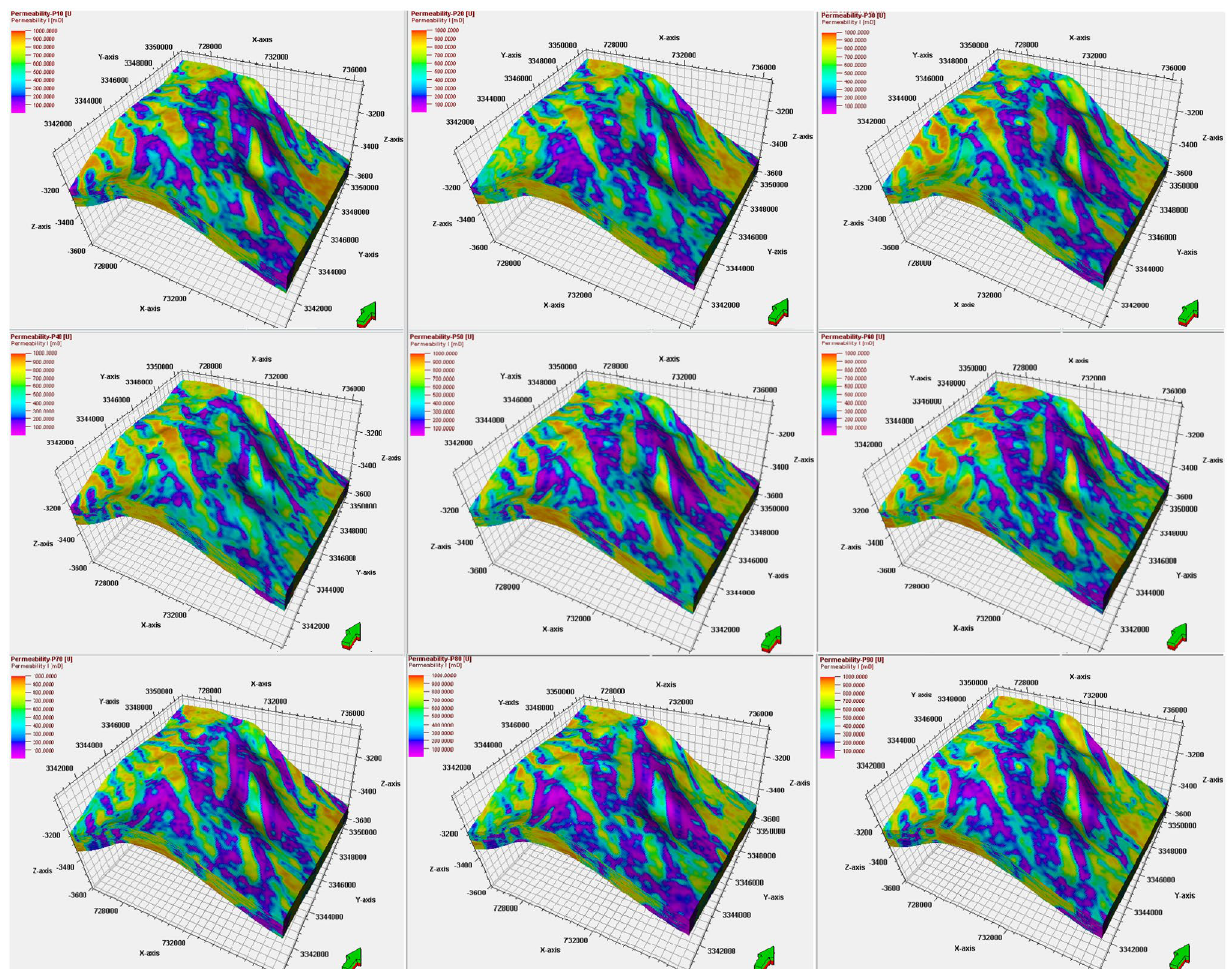
Fig. 8 3D distribution images of the ranked stochastic permeability